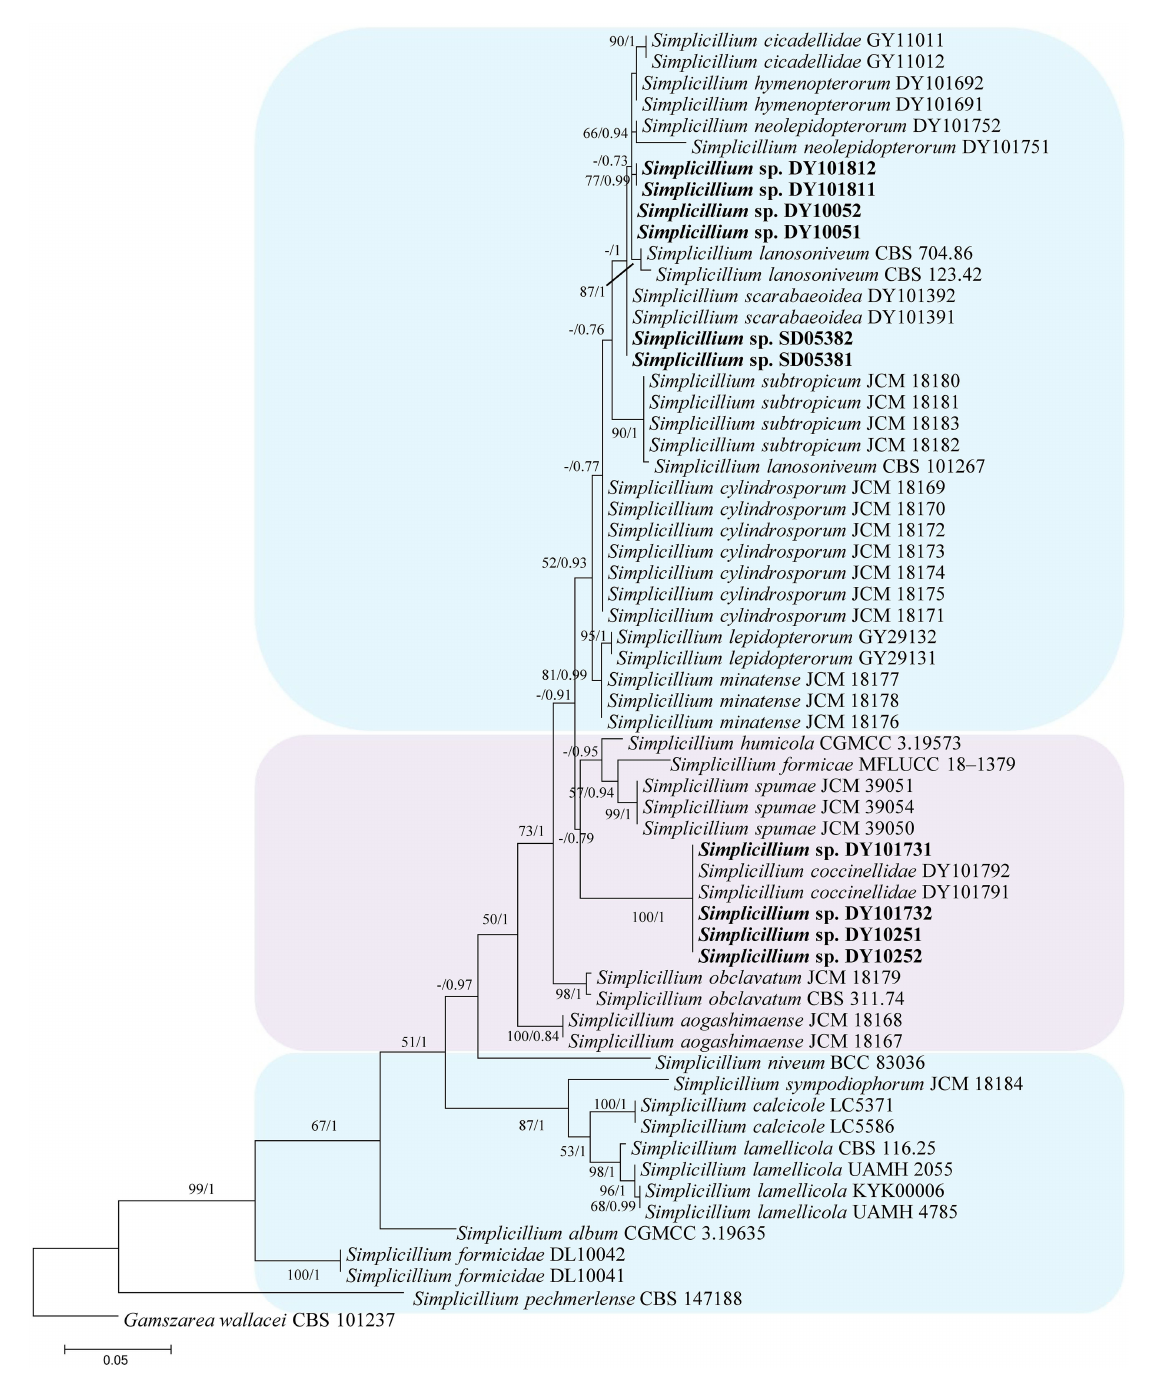
Cai (LC5371 and LC5586), S. formicidae W.H. Chen et al. (DL10041 and DL10042), S. lamellicola (CBS 116.25, KYK00006, UAMH 2055 and UAMH 4785), S. niveum Mongkols., Noisrip.